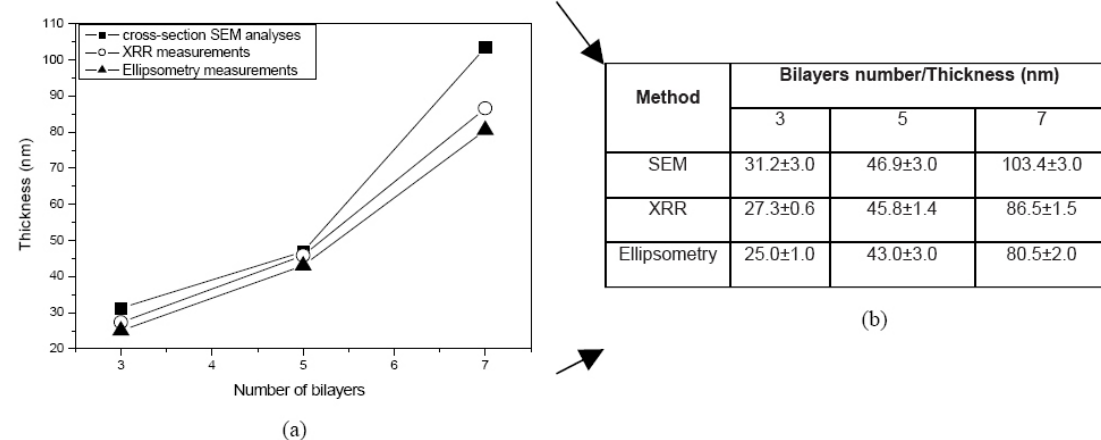
Figure 7. Variation of the deposited polyelectrolytes multilayers on silanized silicon surface with the bilayers